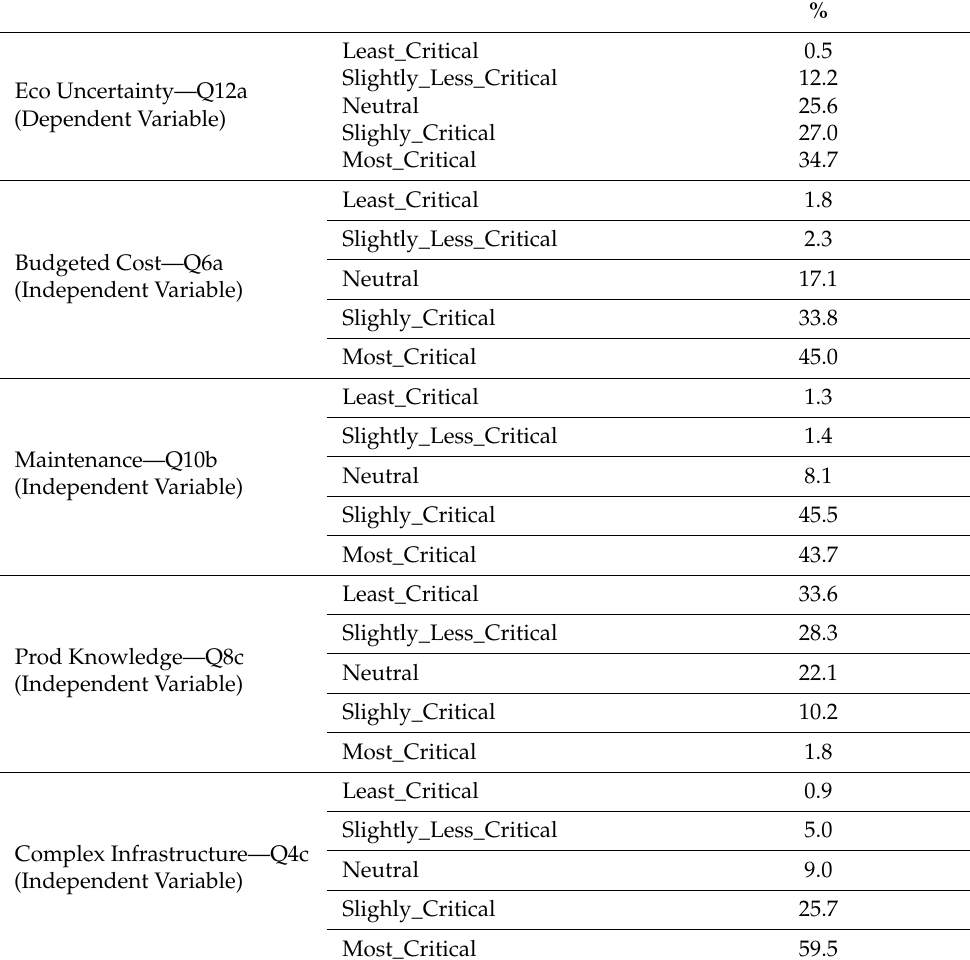
Table 4. Ordinal Regression Case Processing